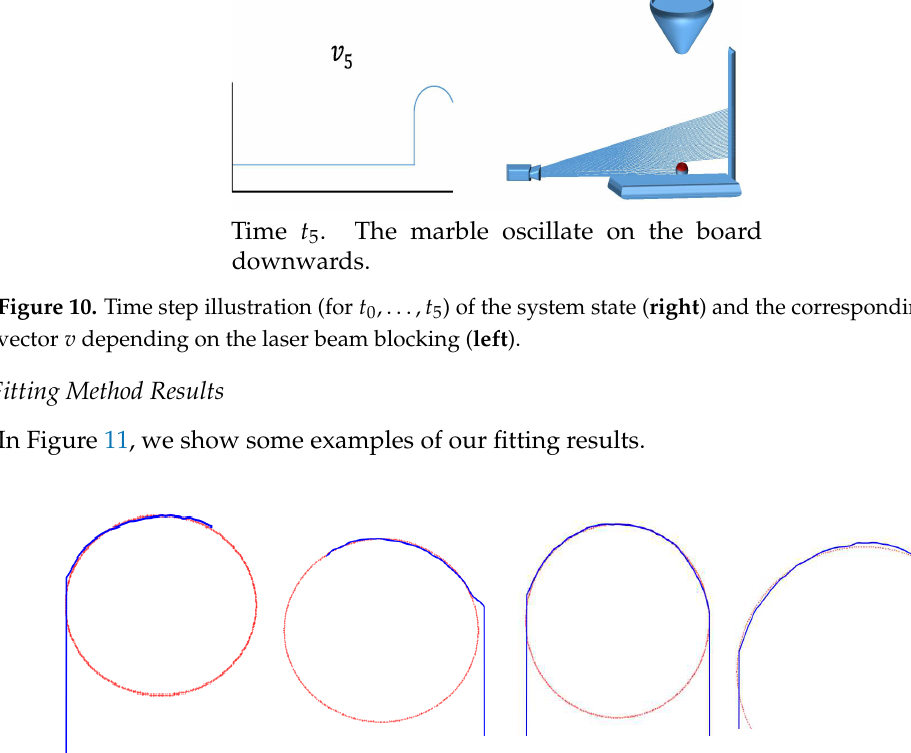
Figure 11. Circle fitting: The following images show examples for fitting circles ( red ) to a set of points ( blue ) with high accuracy as required by the system. Although the samples contain noise and distortions, using our system, we were able to fit an accurate circle to all the